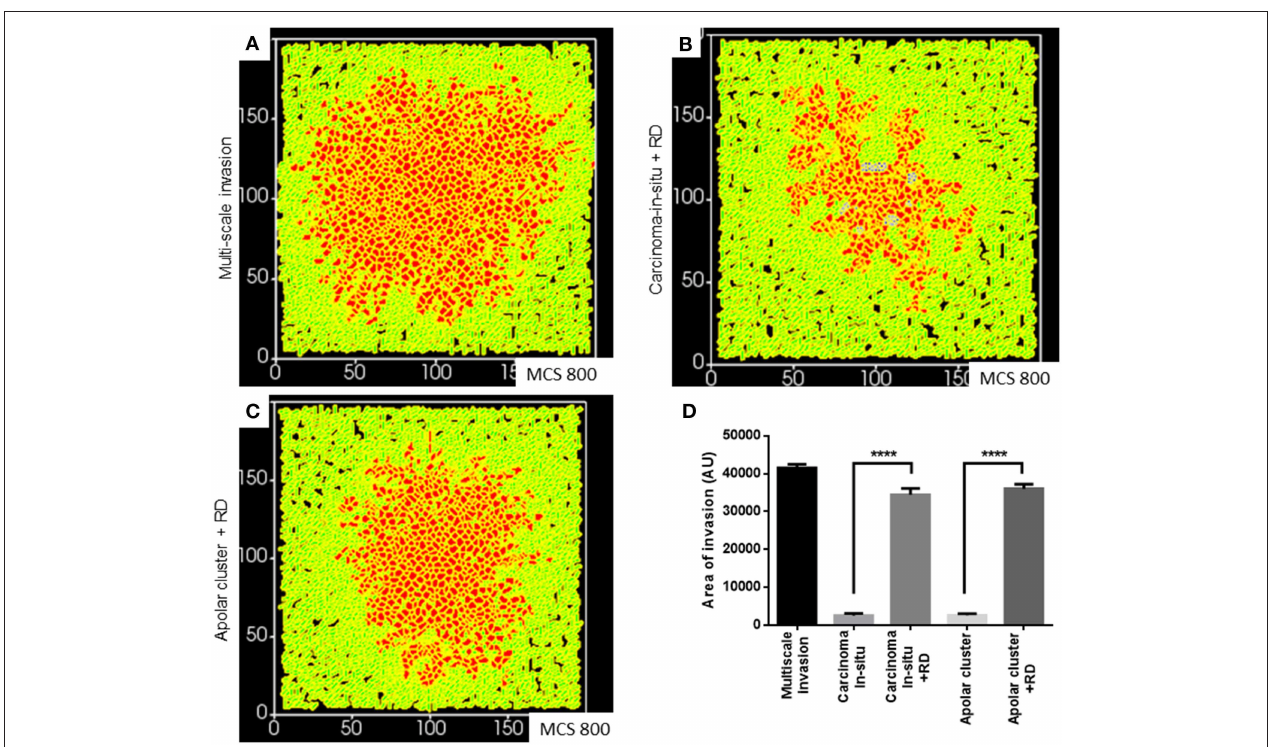
FIGURE 7 | Simulations of the deployment of R-D-based kinetics in carcinoma in situ and subinvasive cluster phenotypes. (A) Simulation of a control multiscale invasion. (B) Simulation, within which regulation of the ECM was modeled using R-D kinetics in parameter regimes of adhesion cognate to carcinoma in situ phenotypes, predicts collective but not single-cell invasion. (C) Simulations, within which regulation of the ECM was modeled using R-D kinetics in parameter regimes of adhesion cognate to subinvasive apolar cluster phenotypes, predict multiscale invasion. (D) Quantification of the invasiveness of cells from the above simulations in comparison with control multiscale invasion. Each bar represents mean ± SEM. **** p <